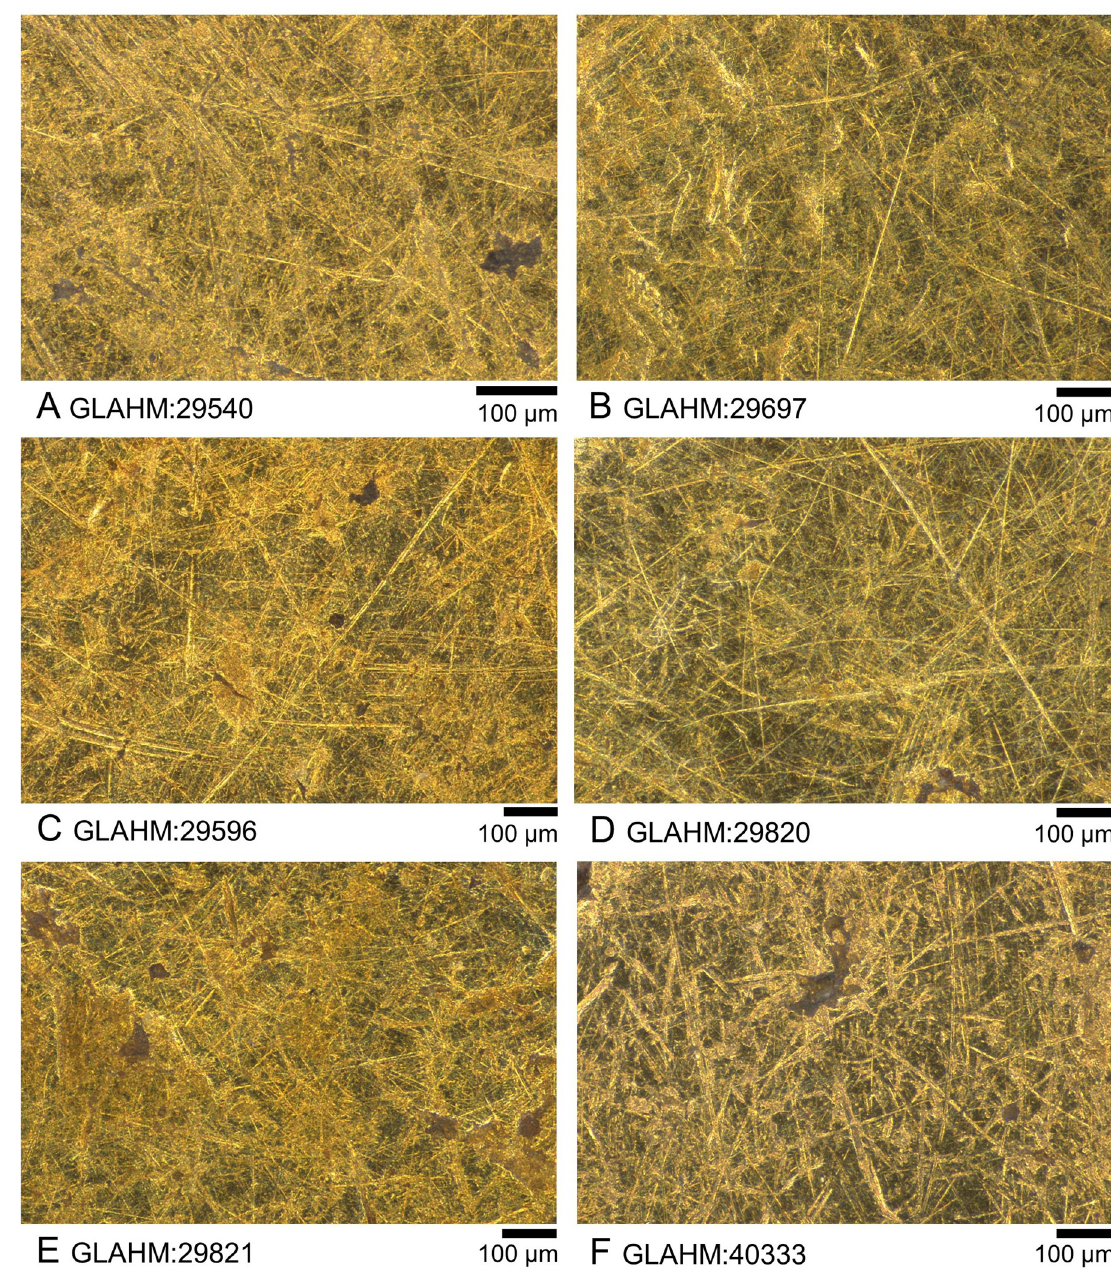
Fig 6. Light microscope images of exposed upper areas on the obverse of the six coins. The two unquestionably genuine coins are at the top. A) GLAHM:29540; B) GLAHM:29697; C) GLAHM:29596; D) GLAHM:29820; E) GLAHM:29821; F)